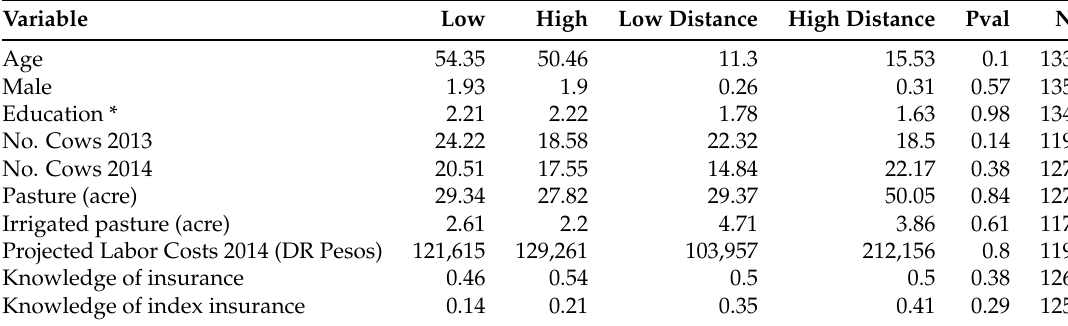
Table 3. Balance Across High and Low Distance Groups.